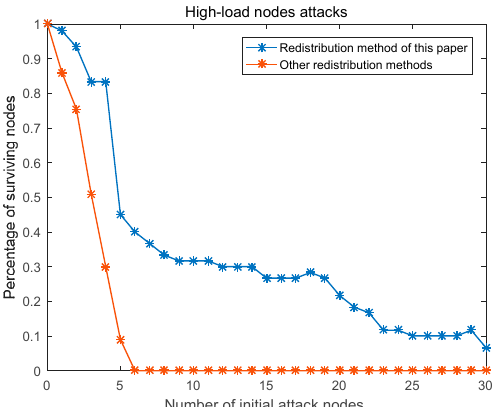
Figure 12. Comparison of survivability under different allocation methods.